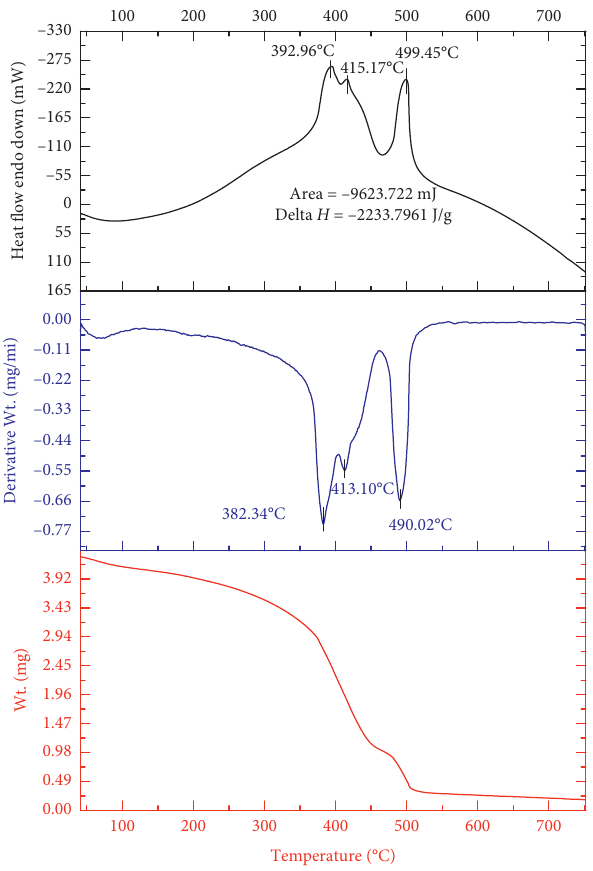
Figure 4: Thermogram of the Mo-OTC/Sal